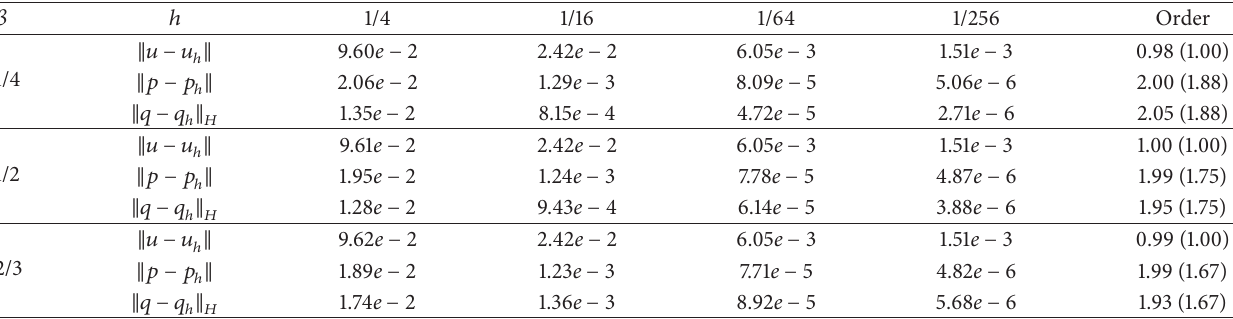
Table 3: Numerical result of Example 2 on a uniform mesh of size ℎ for 𝑘 = 1 .